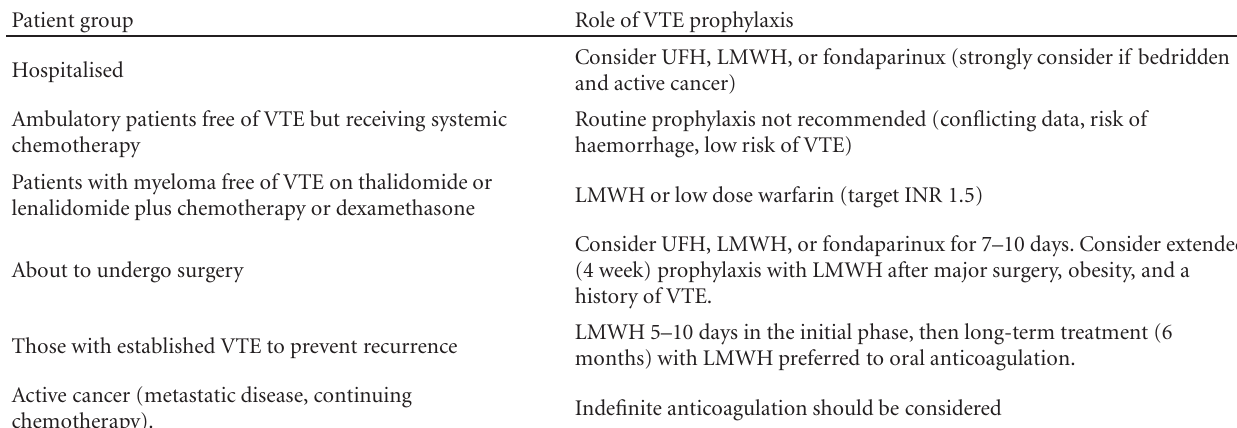
Table 2: Potential treatments of patients with cancer.